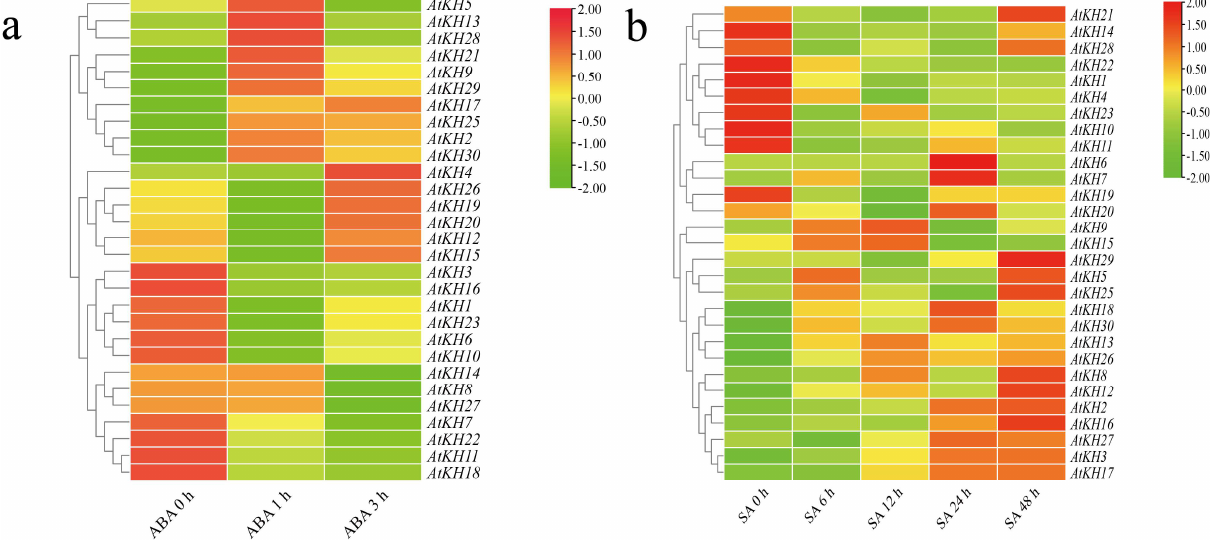
Figure 5. The expression of Arabidopsis thaliana KH domain genes under treatments of ABA and SA. ( a ). The expression of 30 A. thaliana KH genes at 0 h, 1 h, and 3 h after treatment with ABA in the wild-type Col-0. ( b ). The expression of 30 A. thaliana KH genes at 6 h, 12 h, 24 h, and 48 h after SA treatment .